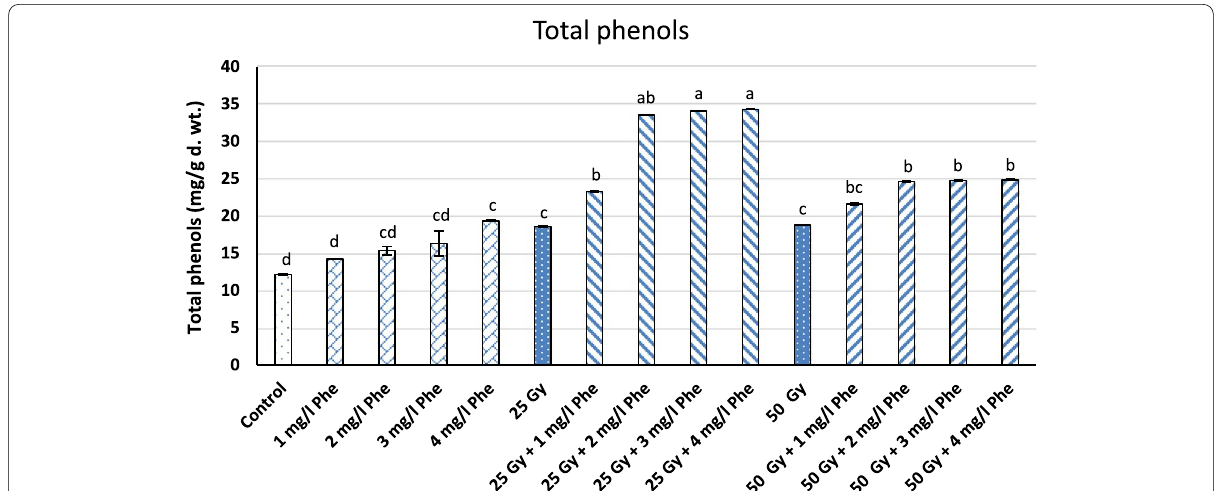
Fig. 2 Total phenolic content under treatment of different combinations of γ‑radiation (25 and 50 Gy) and Phe (1, 2, 3, and 4 mg/l) in the callus cultures of S. marianum L. Different letters on the bars indicate a significant difference at P